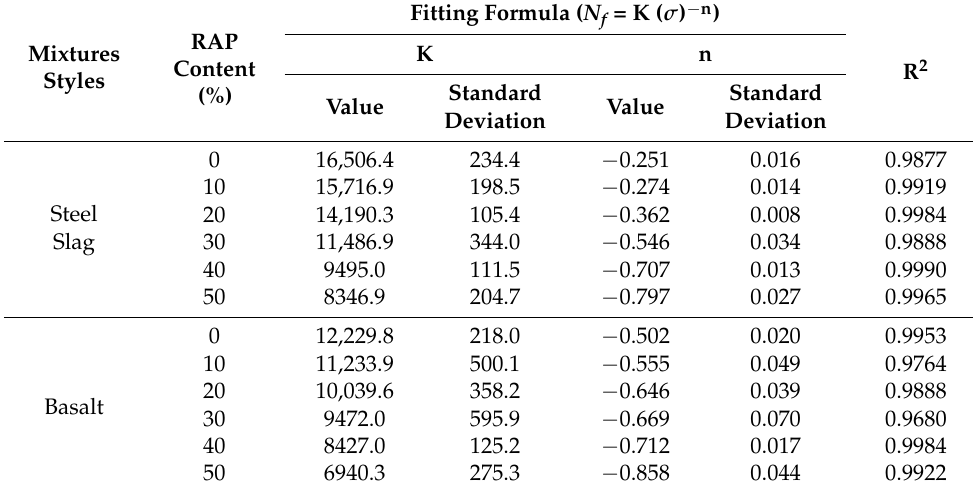
Table 4. Fitting coefficient of fatigue equation for